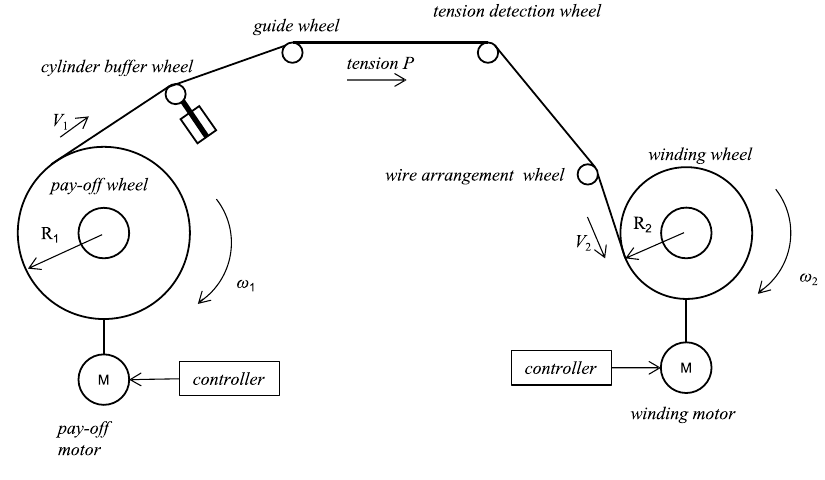
Figure 1. Structure diagram of the high-voltage coil winding machine.